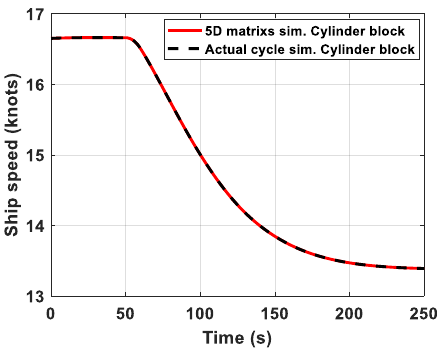
Figure 31. Ship speed time history.